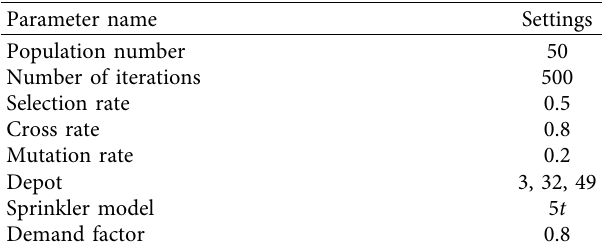
Table 2: Parameter